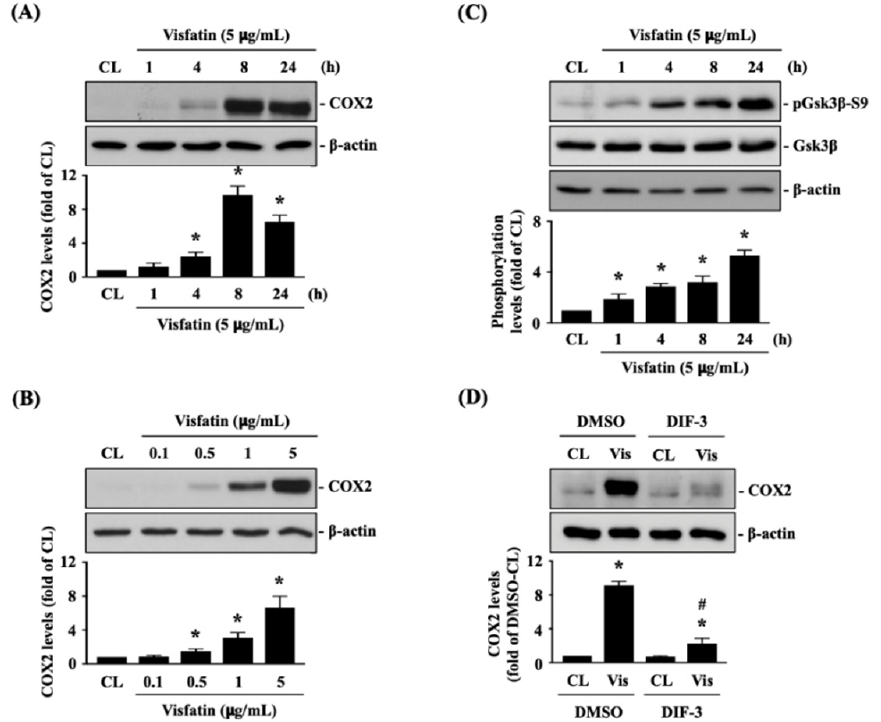
Figure 1. Visfatin inactivates GSK3 β to increase catabolic COX2 expression in human primary chondrocytes. ( A – C ) Human primary chondrocytes were kept as controls (CL) or treated with 5 µ g/mL of visfatin for 1, 4, 8 and 24 h or treated with 0.1, 0.5, 1 or 5 µ g/mL of visfatin for 8 h and then ( A , B ) COX2 protein expression and ( C ) GSK3 β -Ser-9 phosphorylation were analyzed by Western blot. ( D ) Human primary chondrocytes were pretreated with DMSO or DIF-3, a GSK3 β activator, for 1 h and then kept as controls (CL) or treated with 5 µ g/mL of visfatin (Vis) for 8 h. COX2 expression in human primary chondrocytes was analyzed by Western blot. Results in ( A – D ) are representative of three independent experiments with similar results. Statistical data in ( A – D ) are mean ± SEM from three independent experiments. *, p < 0.05 vs. untreated control cells (CL) or DMSO-CL-treated cells. #, p < 0.05 vs. DMSO-visfatin (Vis)-stimulated cells.